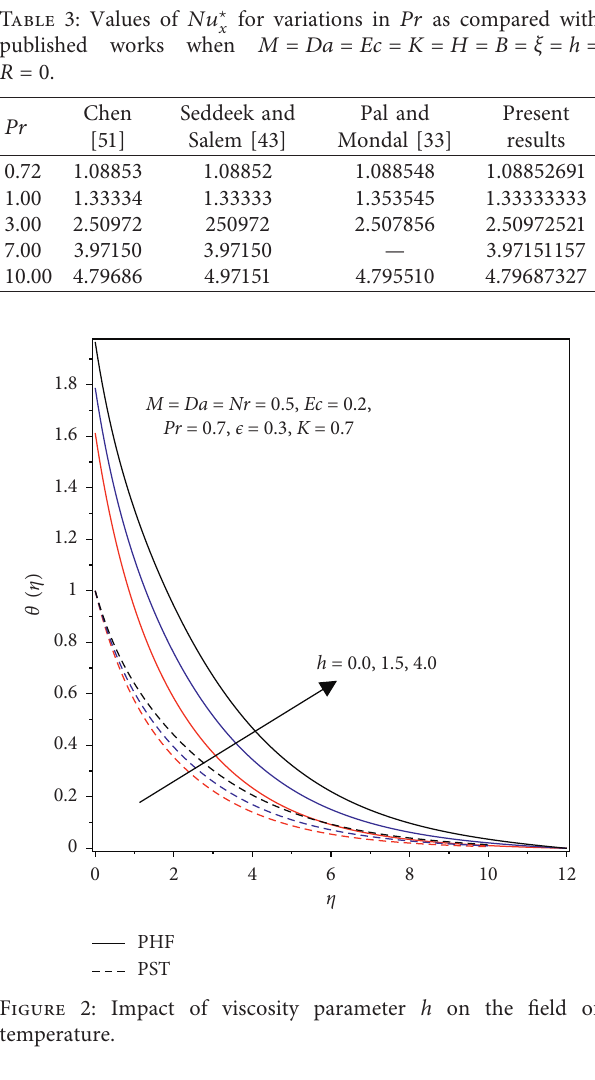
Table 3: Values of Nu ⋆